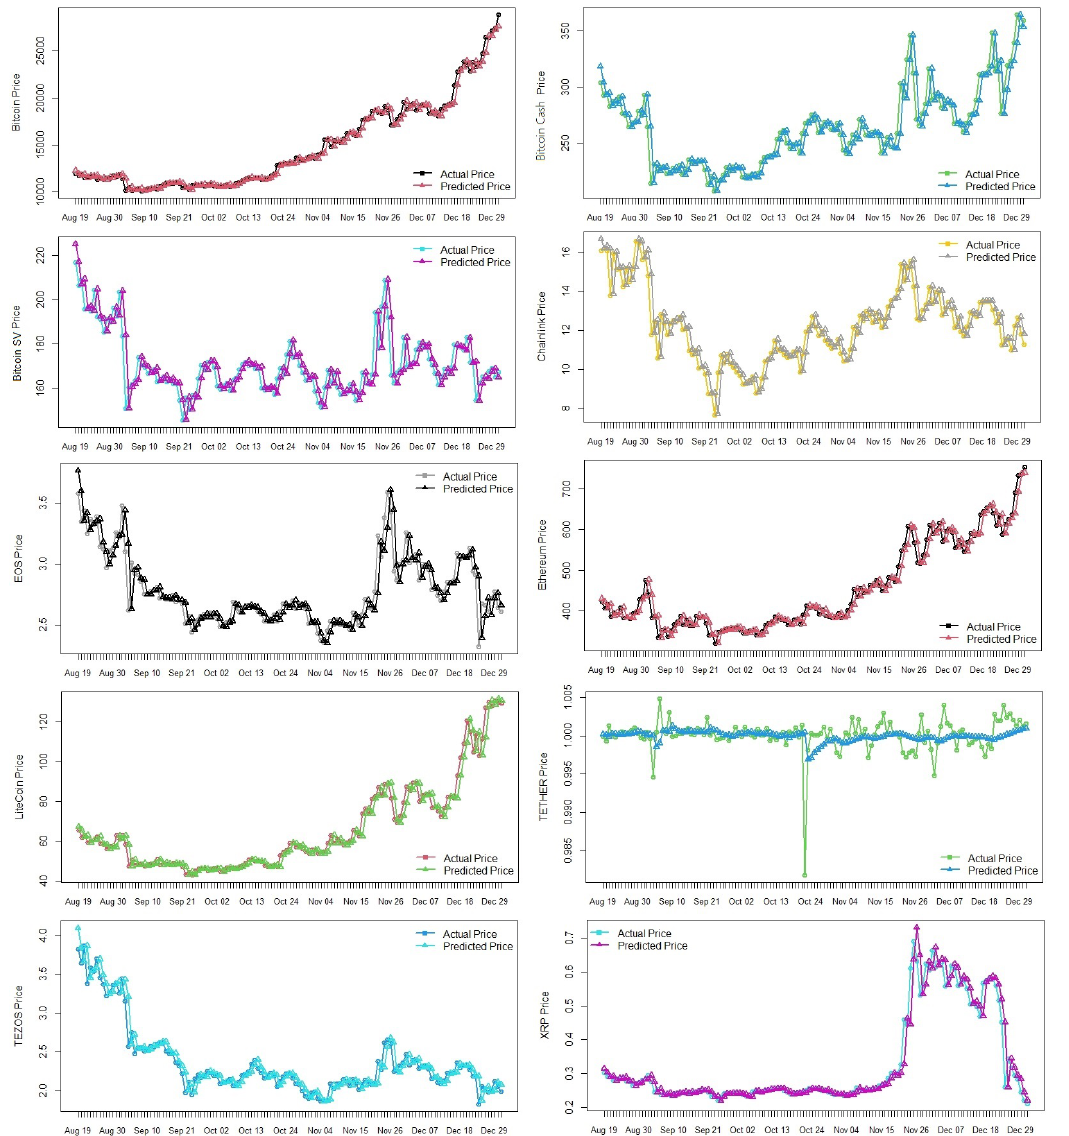
Figure 9. Predicted prices of the cryptocurrencies by the ARIMA